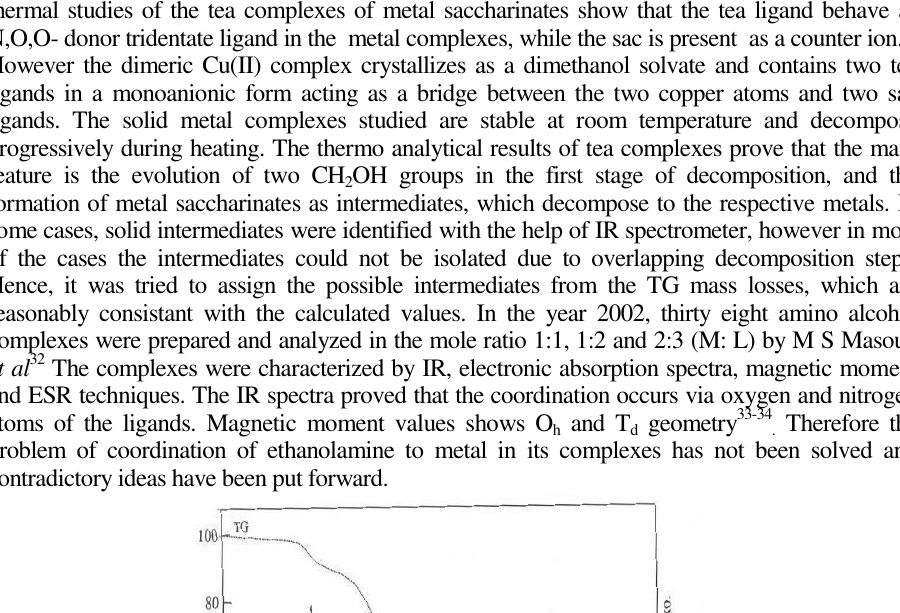
](sac) heated at 10 0 C min -1 in N 2 2